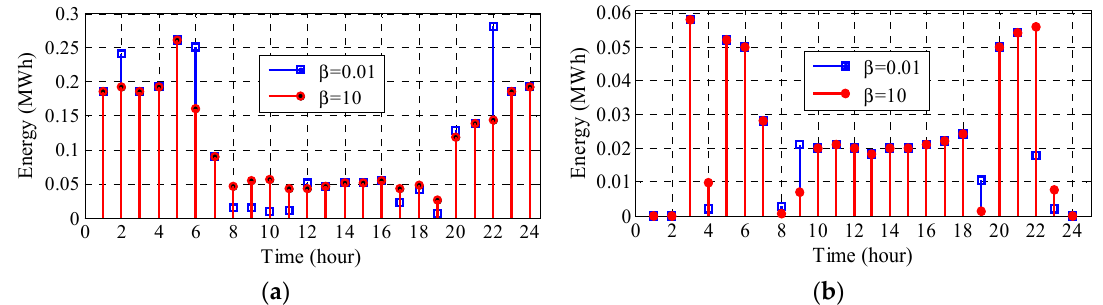
Figure 7. Share of aggregator under study supply to EVs in ( a ) charge process; ( b ) discharge process for β = 0.01 and β = 10.